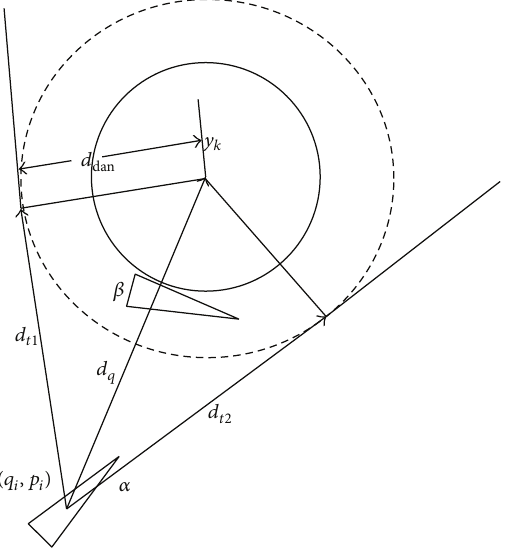
Figure 2: The description of agent and dangerous